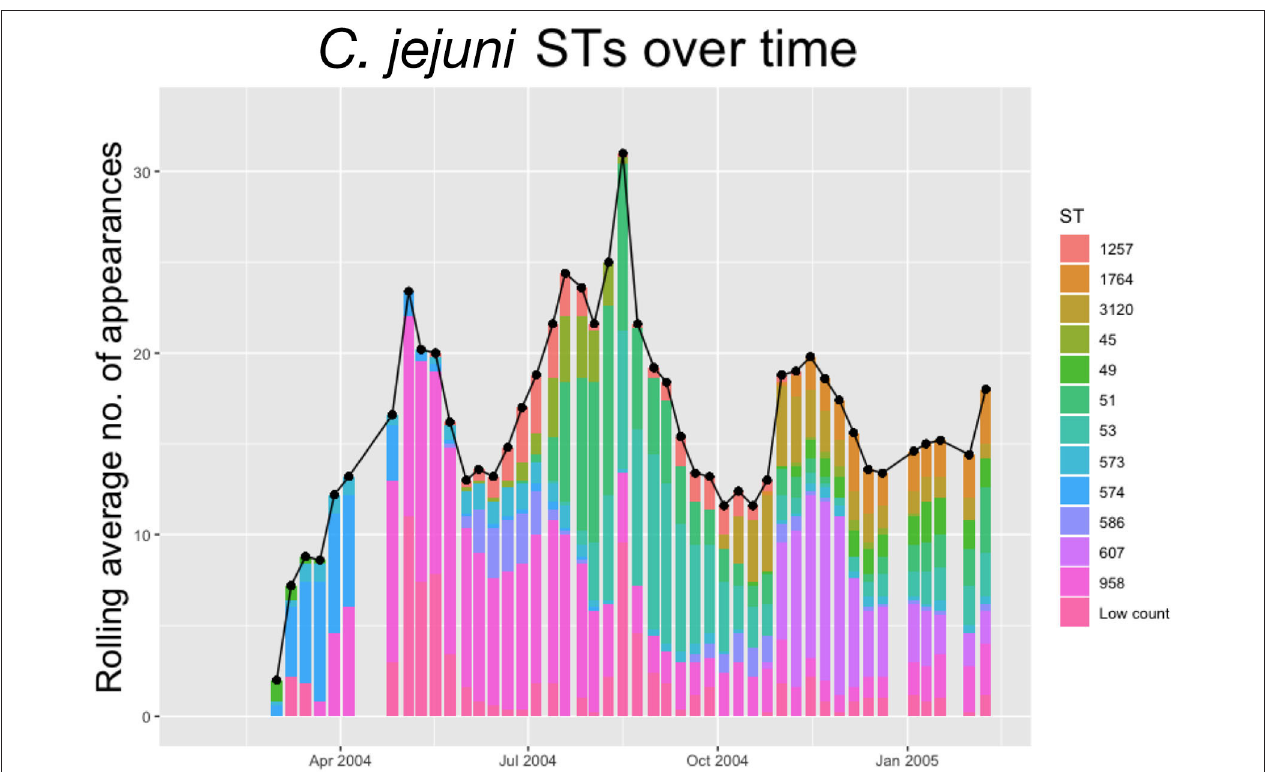
FIGURE 2 | The 5-weeks rolling average number of positive samples for Campylobacter jejuni , with both the total number and separate ST averages. STs that appear < 20 times throughout the entire experiment are amalgamated into a group “Low